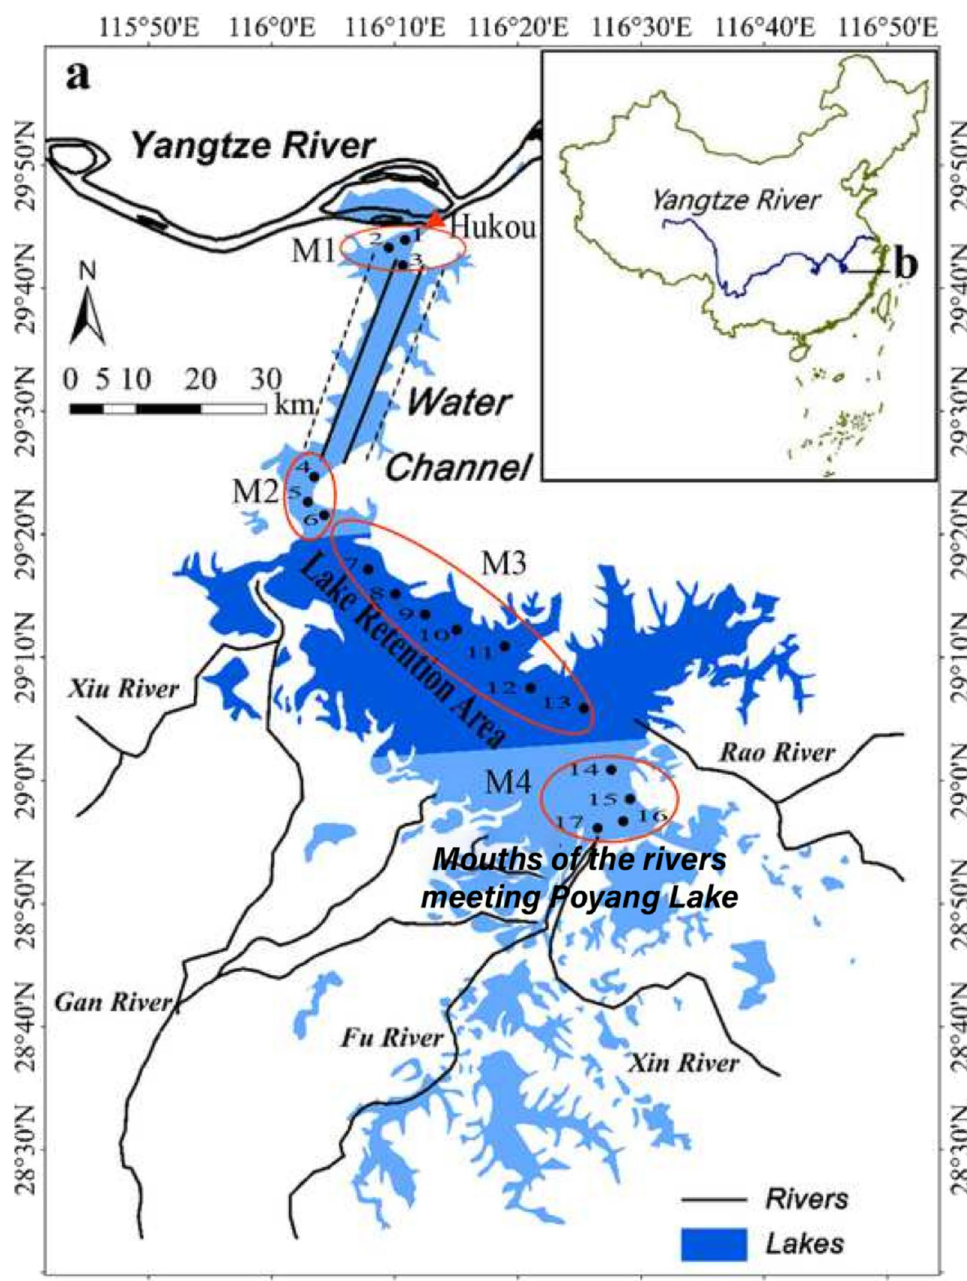
Fig. 1 Map showing the study area in Poyang Lake,